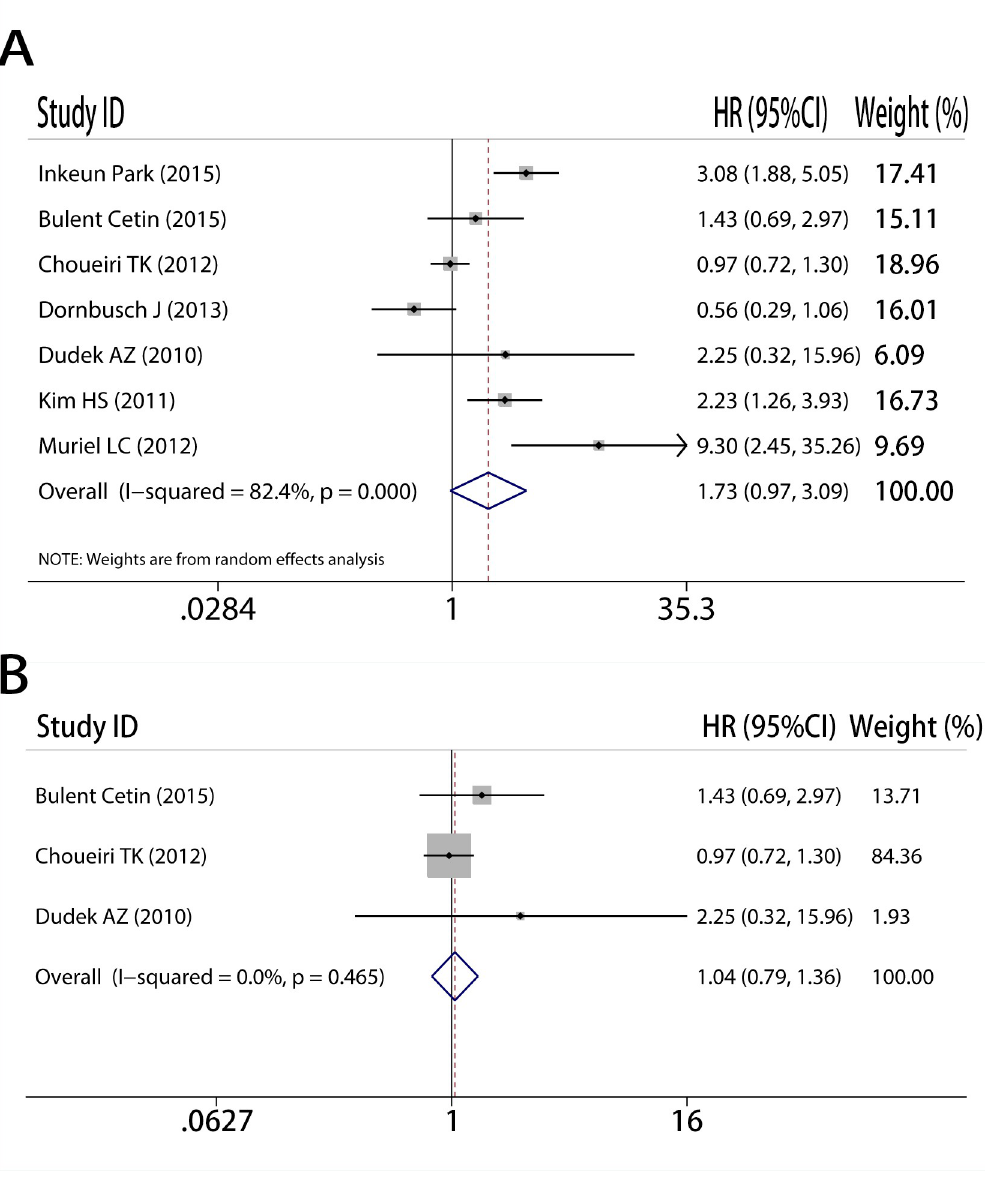
Fig 5. Meta-analysis of CAIX expression and progression-free survival on A, all inclusion studies; B, by excluding the low quality score studies (quality score � 6).